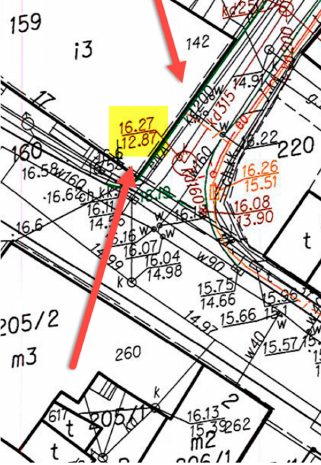
Figure 11. Ground work map—ordinate of replaced pipe near studied